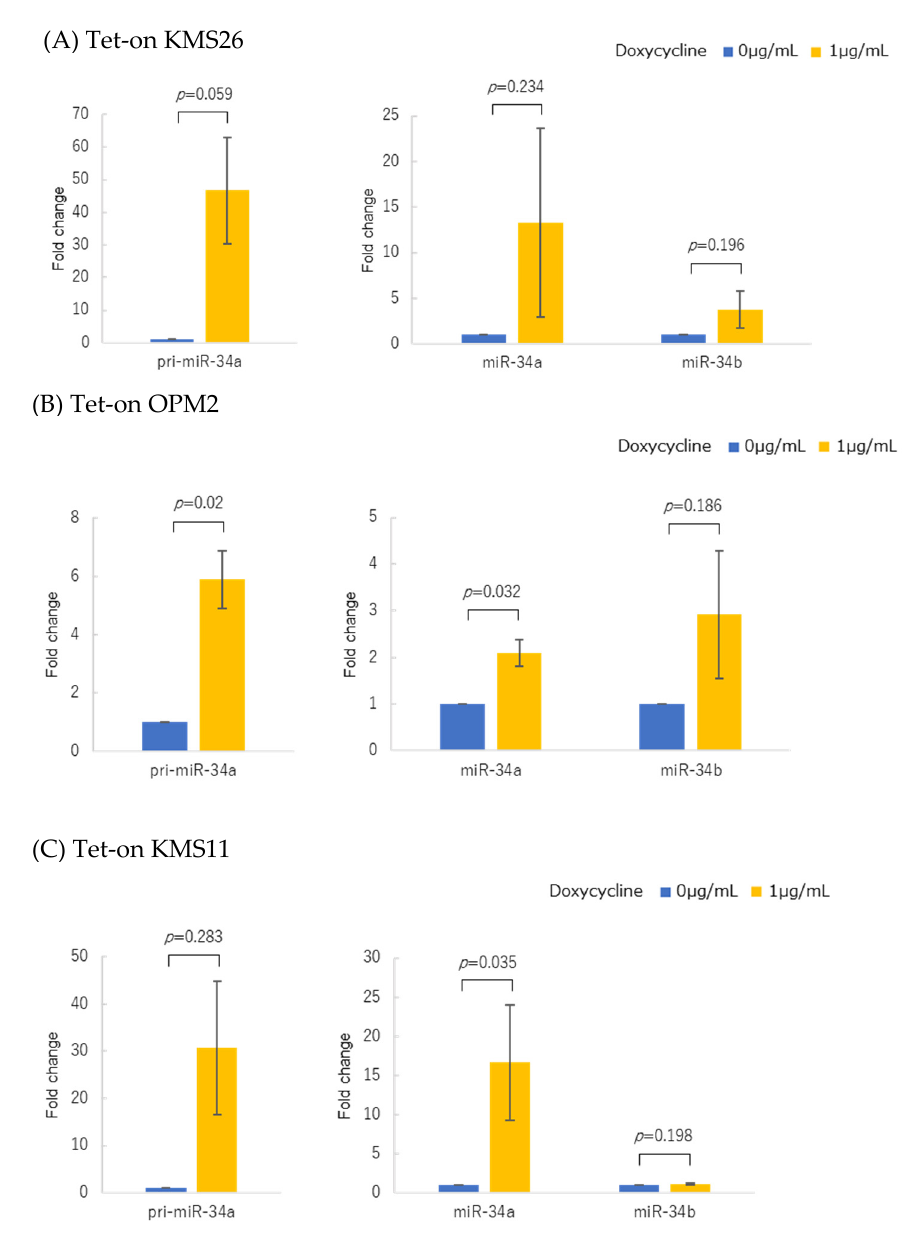
Figure 3. Changes in pri-miR-34a and mature miR-34a/b expressions in response to doxycycline in three Tet-on p53 myeloma cell lines. ( A ) KMS26, ( B ) OPM2, and ( C ) KMS11 were treated for 24 h with either 0 µg/mL or 1 µg/mL doxycycline. Experiments with KMS11 were performed four times, while the others were performed in triplicate. Error bars show the standard deviation (SD) across the experiments. Blue, with 0 µg/mL doxycycline; yellow, with 1 µg/mL doxycycline.